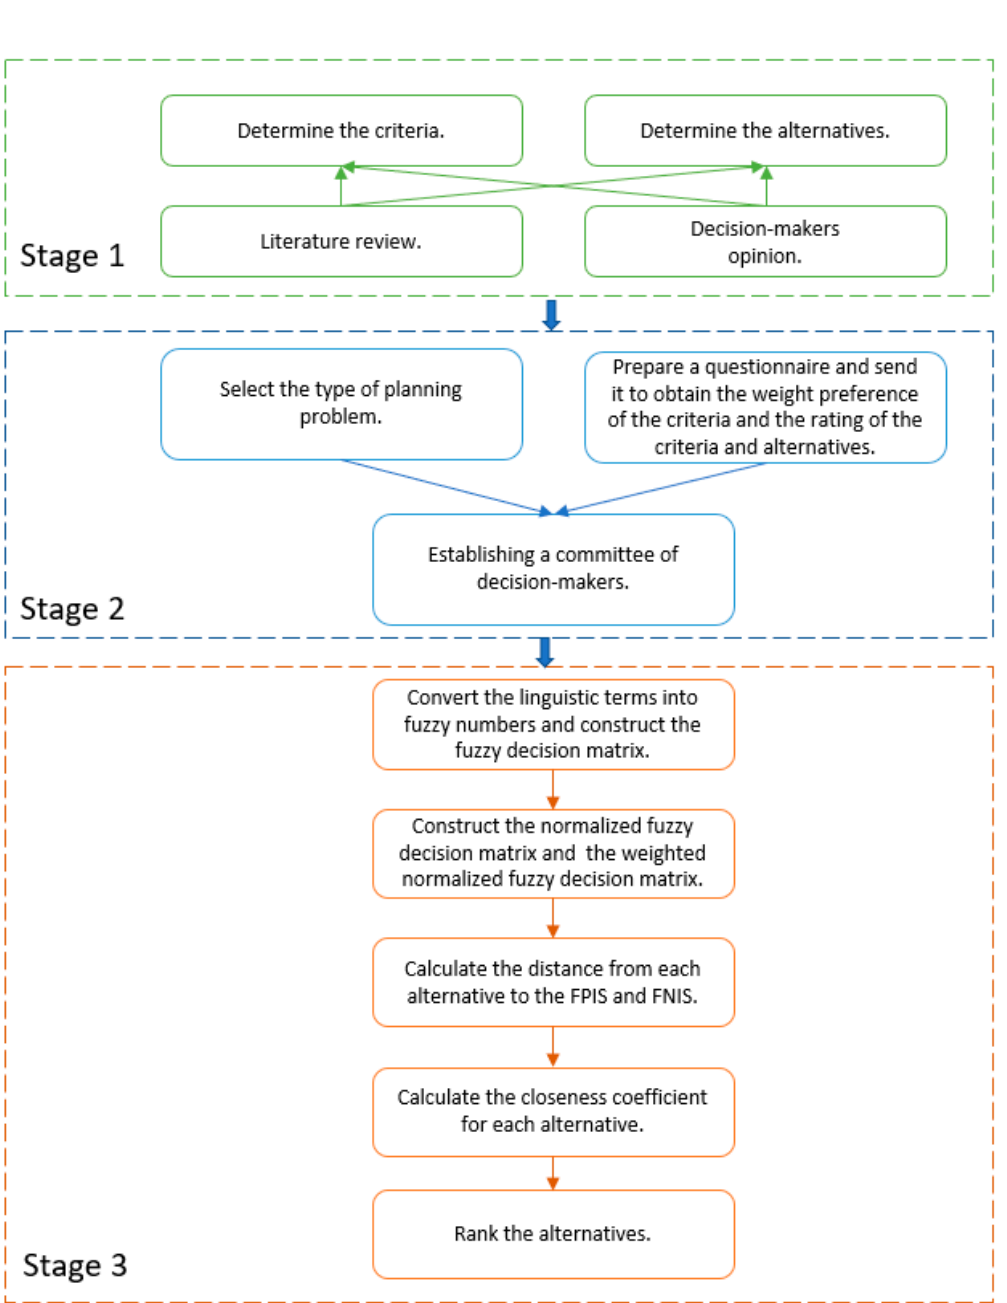
Figure 2. A methodological approach for the algorithm selection problem.